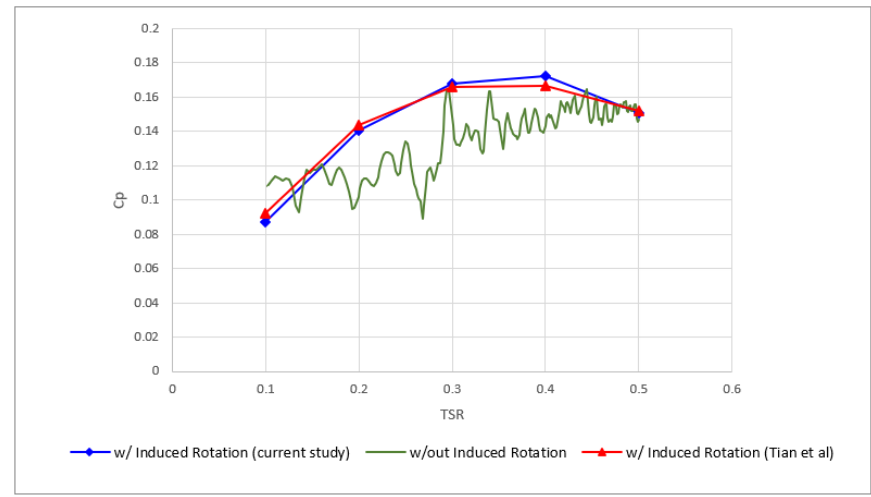
Figure 17. (cid:1829) (cid:3017) versus TSR for VAWT simulated from steady wind of 4.4 m/s. Figure 17. C P versus TSR for VAWT simulated from steady wind of 4.4 m/s.